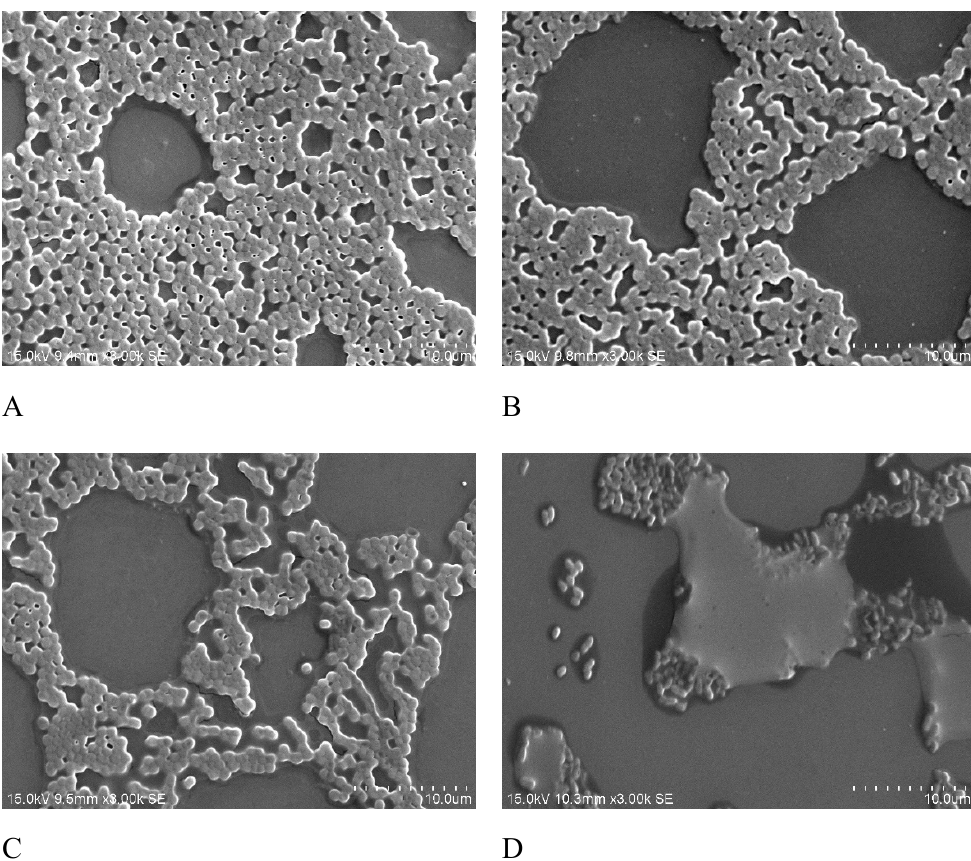
Figure 4. Scanning electron microscopy (SEM) images of A. baumannii treated with imipenem. A , After 4 hr of treatment with 16 µg/mL imipenem; B , After 4 hr of treatment with 32 µg/mL imipenem; C , After 8 hr of treatment with 16 µg/mL imipenem; D , After 8 hr of treatment with 32 µg/mL imipenem. Magnification 3000×; Bars = 10 µm.